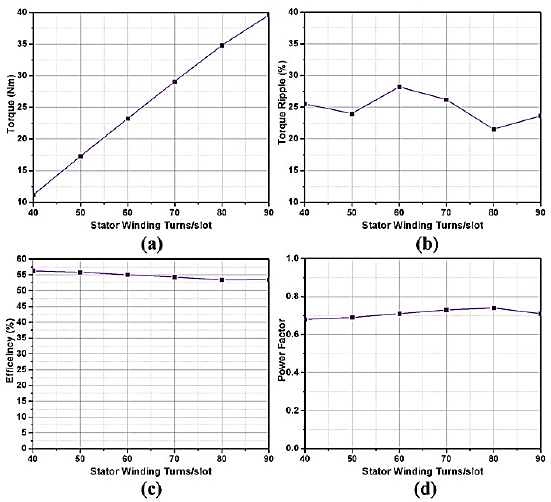
Figure 9. Effect of variation of stator winding turns on machine performance ( a ) torque; ( b ) torque ripple; ( c ) efficiency; and ( d ) power factor.